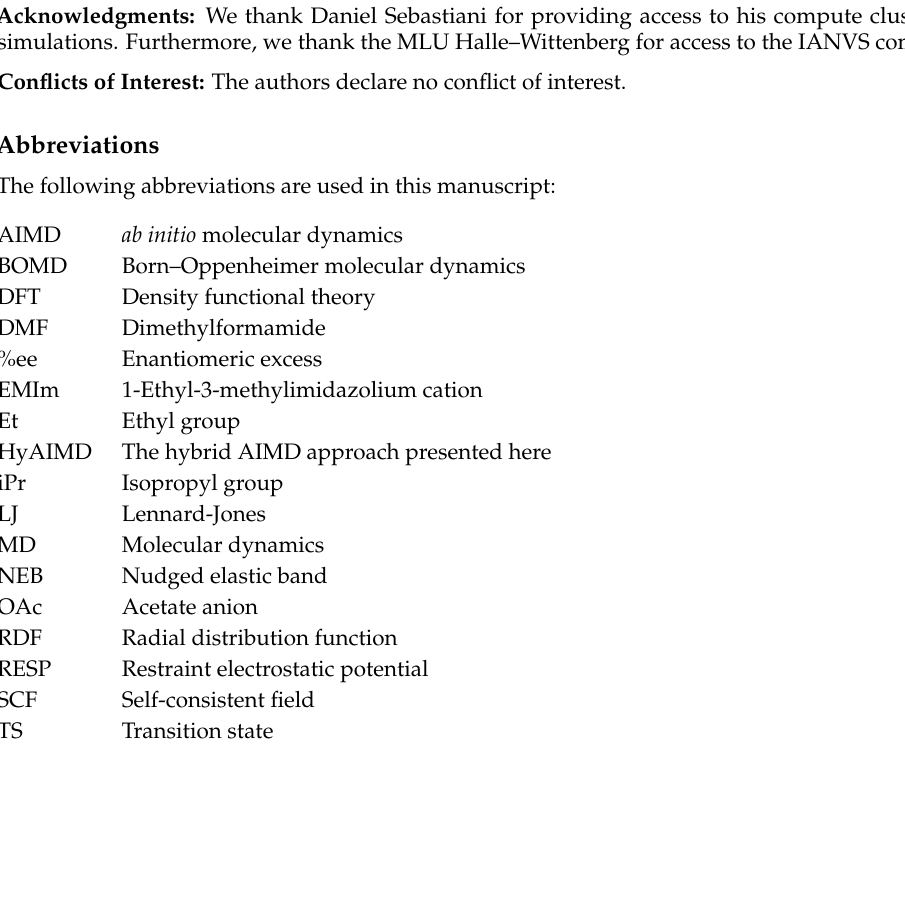
R = iPr from static NEB calculations, Table S3: Total reaction free energies and free energy barriers of aldol reaction in vacuum with R = Et from metadynamics, Table S4: Total reaction free energies and free energy barriers of aldol reaction in DMF with R = Et from metadynamics, Table S5: Total reaction free energies and free energy barriers of aldol reaction in vacuum with R = iPr from metadynamics, Table S6: Total reaction free energies and free energy barriers of aldol reaction in DMF with R = iPr from